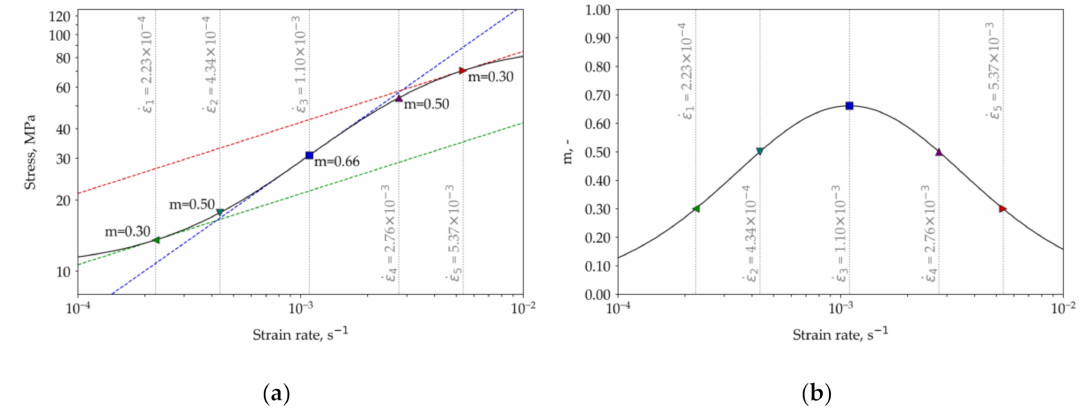
Figure 9. A sigmoidal material model and the strain rates used in the simulations: ( a ) the relation between the stress and strain (solid) and the Backofen approximations for three selected strain rates (dashed) plotted in logarithmic scale; ( b ) the relation of strain-rate sensitivity index on the e ff ective strain